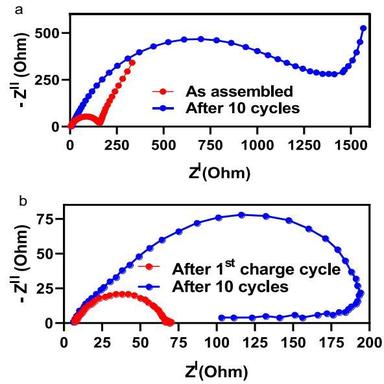
(a) Electrochemical impedance spectra of the electrode as assembled at OCP (2.4 V) and discharged after 10 cycles (3.5 V). AC amplitude 10 mV, frequency range 10 mHz-1 MHz, T=20 °C, 1 M LiPF6 dissolved in EC-DMC (1:1 vol) as electrolyte, Celgard used as separator. (b) Electrochemical impedance spectra of the electrode at charged state (0.5 V) after first charge and after 10 cycles. AC amplitude of 10 mV, frequency range 10 mHz-1 MHz, T=20 °C, 1 M LiPF6 dissolved in EC-DMC (1:1 vol) as electrolyte, Celgard